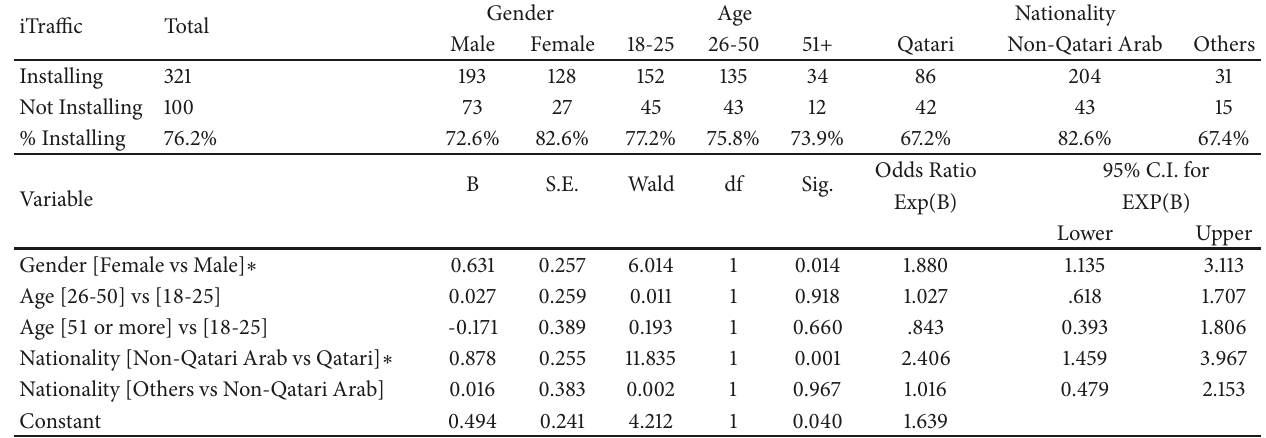
Table 3: Drivers’ choice of installing/not installing iTraffic and logistic model results.